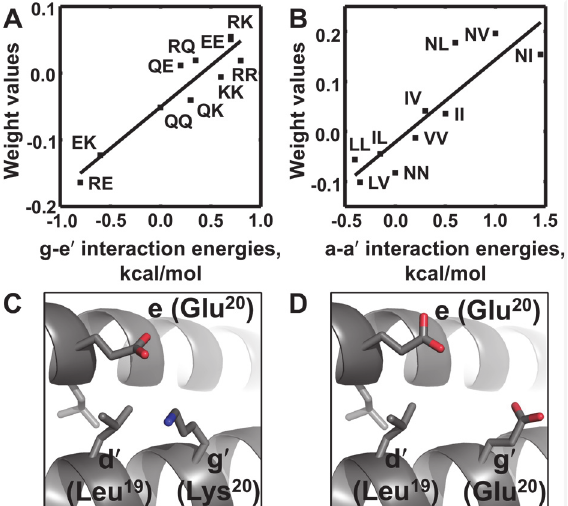
Fig 2. Interpretation of the model weights. Optimized weights correlate with experimentally measured coupling energies reported in the literature: (A) g - e ' R ge = 0.94 ( p = 5x10 – 5 ) and (B) a - a ' R aa = 0.89 ( p = 6x10 – 4 ) [5,22,23]. (C, D) Examples illustrating triplets of residues that are predicted to be stabilizing (C) or destabilizing (D) according to the derived model. PDB ID 4DMD was used to illustrate the triplets; the structure in panel (D) was obtained by modeling glutamic acid at position 20 using the SCWRL4 side-chain prediction program [57].